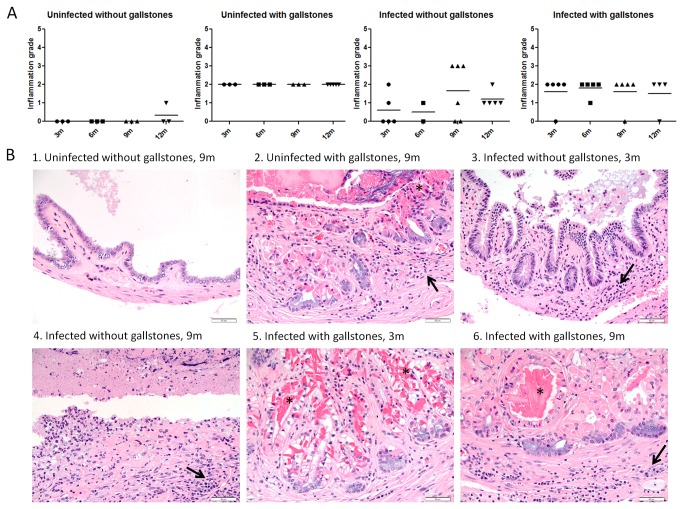
Chronic cholecystitis occurs as a result of both gallstone disease and Salmonella carriage.(A) Inflammation grades in the gallbladder at all time points post-infection (± bacteria, ± gallstones). Means of each time point values were compared by a Student’s t test. No statistical significant difference was observed between values of each time point (p<0.5). (B) Representative HE images of each group at 3 and 9 months post-infection. B1 has an inflammation score of 0; B2, B3, B5 and B6 have a inflammation score of 2; whereas B4 has a score of 3. Hyperplasia was only evident in mice harboring gallstones and with concurrent epithelial hyalinosis (*) (B2, B5 and B6). Black arrows indicate scattered inflammatory cells within the lamina propria and muscularis, they were mainly composed of lymphocytes, plasma cells and fewer neutrophils. 40x.